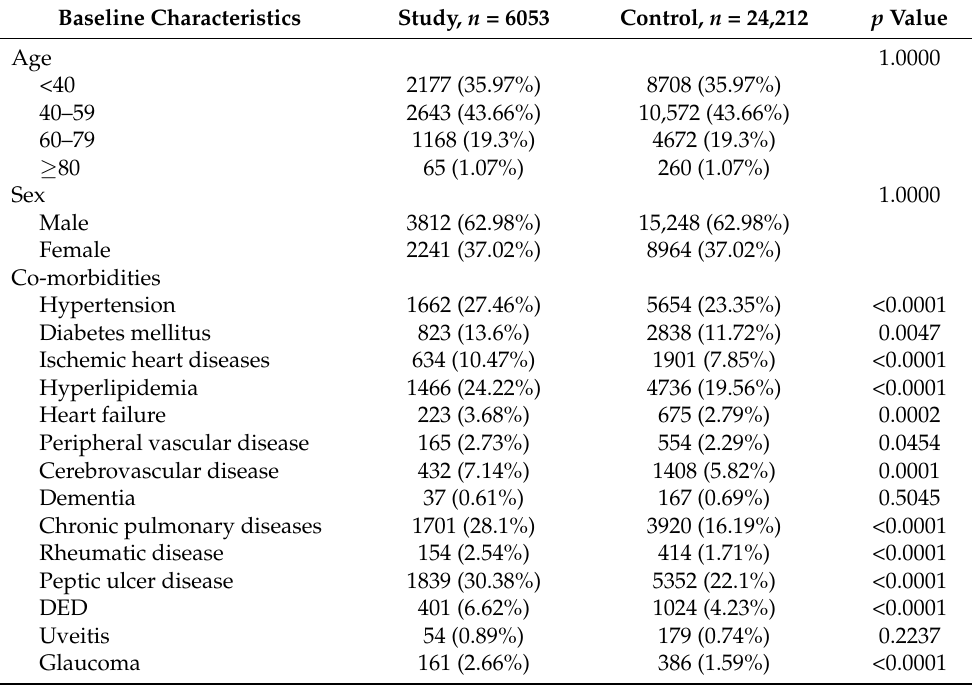
Table 1. Baseline characteristics between the study and control